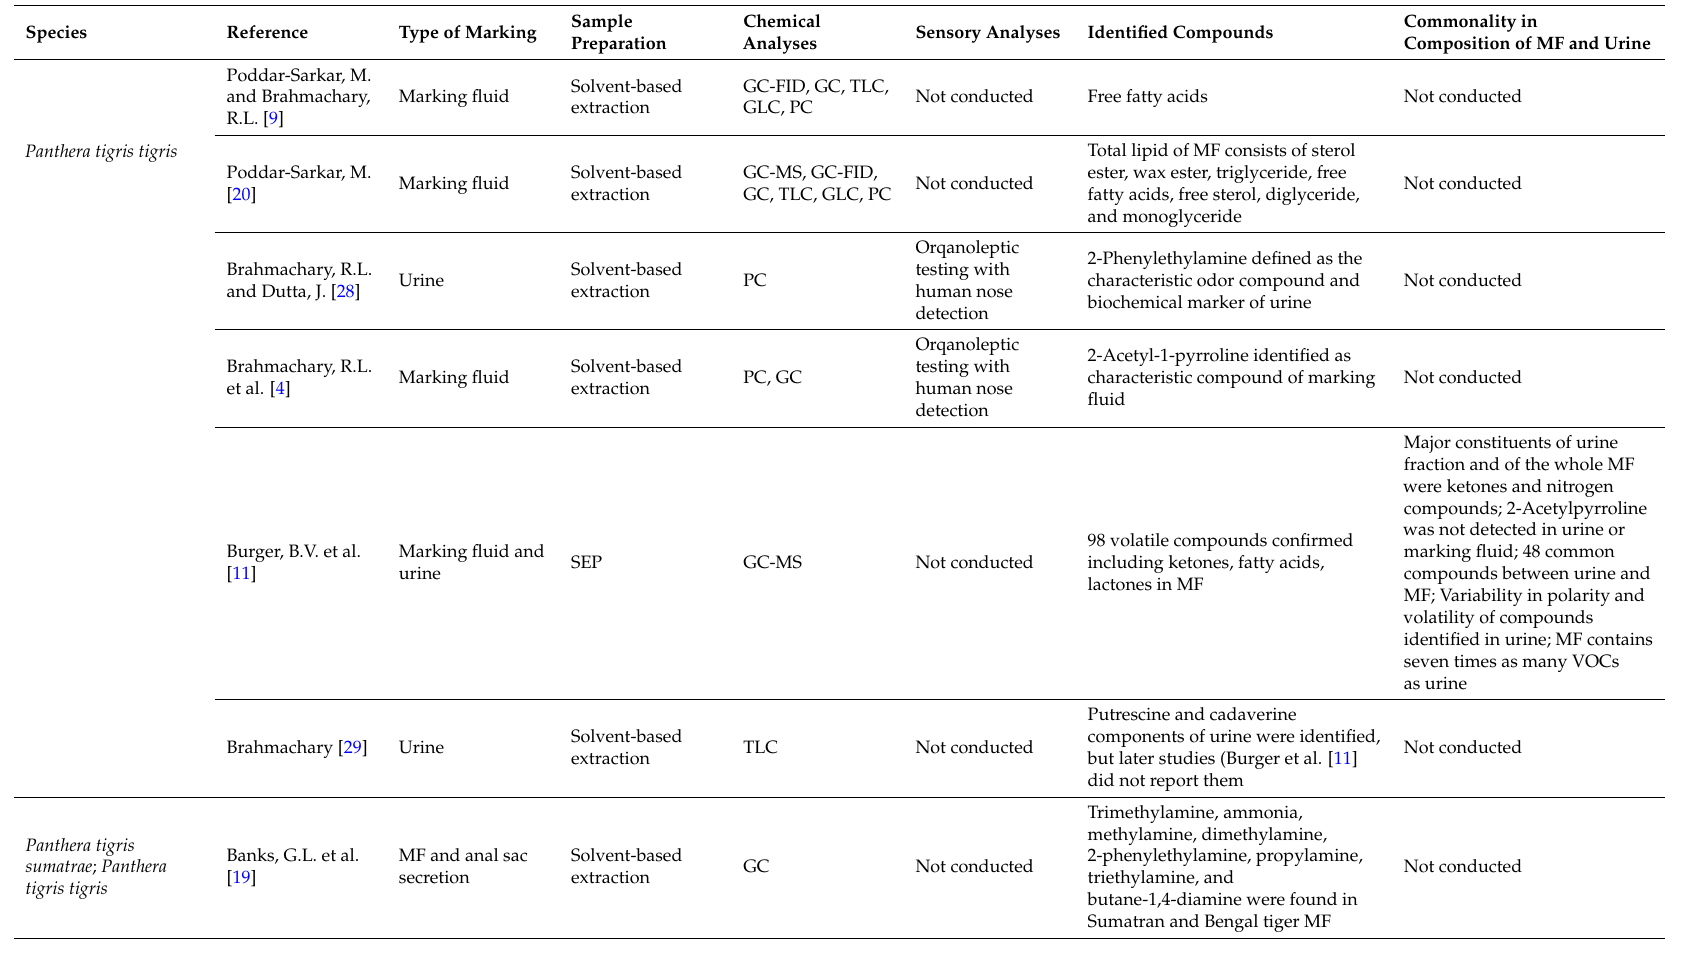
Table 1. Comparison of sample preparation, chemical, and sensory methods used to characterize scent markings, and the relationship between chemical constituents of marking fluid and urine of great